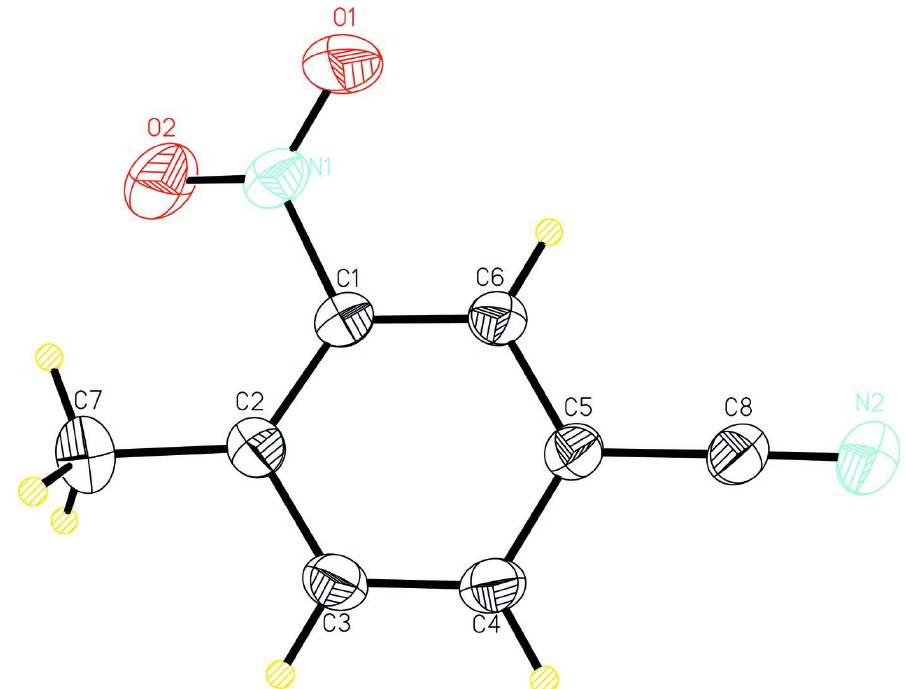
A view of the molecular structure of the title compound, with the atomic numbering scheme. Displacement ellipsoids are drawn at the 30% probability level. H atoms are represented by spheres of arbitrary